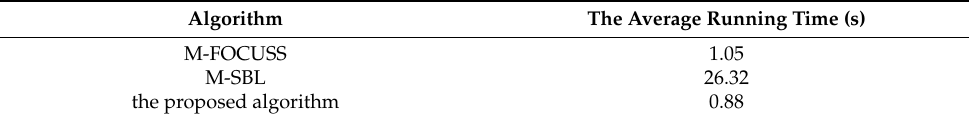
Table 3. Running time of different algorithms for a side-looking radar without off-grid problems.